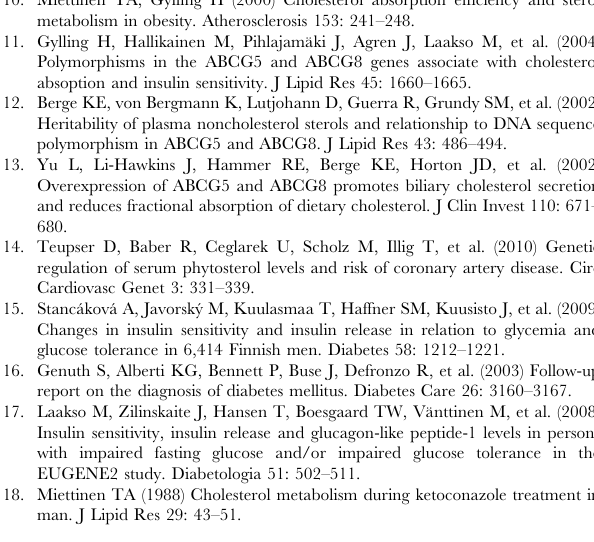
Table S1 Mean level and the range of sterol levels at baseline (N = 746).